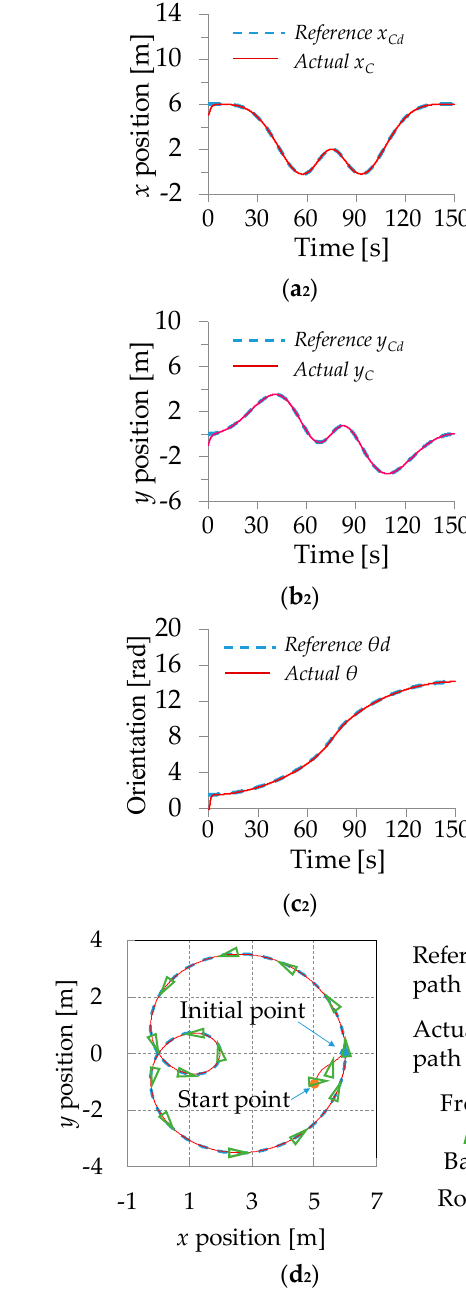
Figure 6. Trajectory and path tracking performance of the robust feedback tracking controller for the rose path (primitive parameters m = 6 kg, r 0 = 0.2 m, α = π /2, R a = 0.56 Ω , and F friction = 0 : ( a 1 ) x position; ( b 1 ) y position; ( c 1 ) orientation θ ; and ( d 1 ) path tracking) (changed parameters m = 26 kg, r 0 = 0.3 m, α = π /3, R a = 0.76 Ω , and F friction = [0.2 N, 0.2 N, 0.3 N ∙ m]: ( a 2 ) x position; ( b 2 ) y position; ( c 2 ) orientation θ ; and ( d 2 ) path tracking).